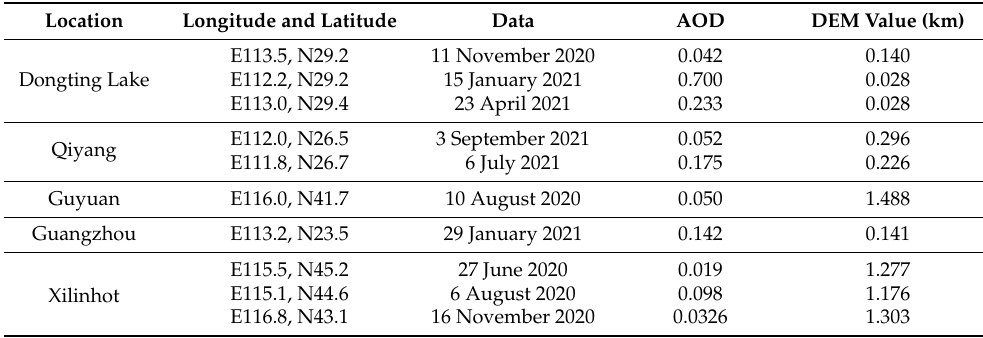
Table 3. The central longitude and latitude, date, and synchronized DEM value and AOD of the five test